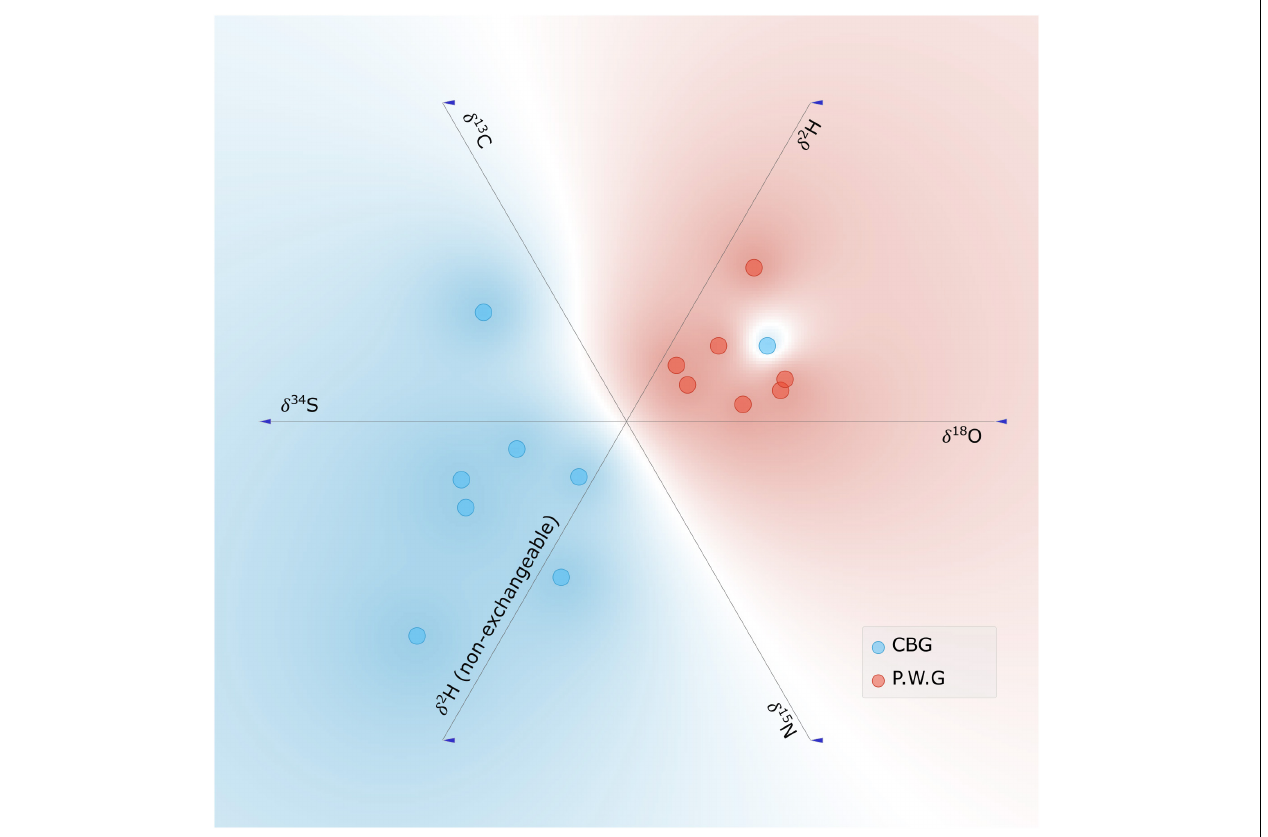
FIGURE 4 | Linear projection of the stable isotope ratios of Aucoumea klaineana samples from the C.B.G ( n = 9) and P.W.G ( n = 7)